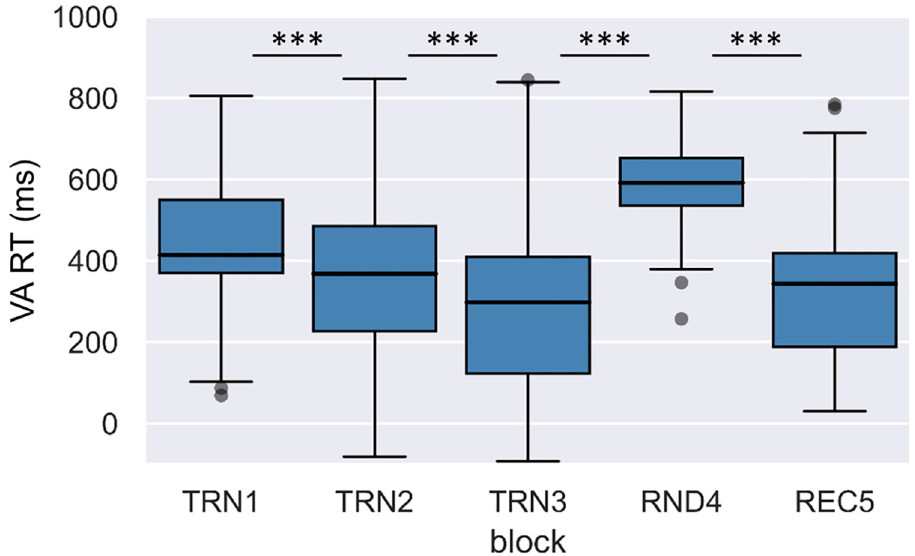
Fig 3. Change of median reaction times through blocks in the verbal acoustic condition. Boxes indicate reaction times between the first and third quartiles, horizontal lines indicate medians, whiskers illustrate the range of data, and individual dots outside the range represent outliers.